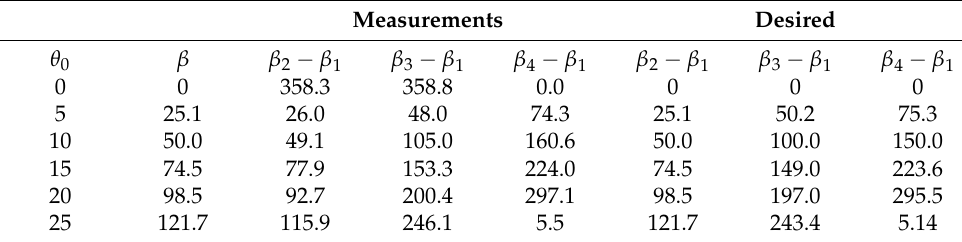
Table 2. Measured and desired phase shift (in degrees) produced by each of the phase shifters in the WRPS to scan the main lobe of the array to different directions θ 0 ( β is the necessary progressive phase shift for each scanning direction and β i , i = 1,..,4 is the phase shift that each phase shifter must